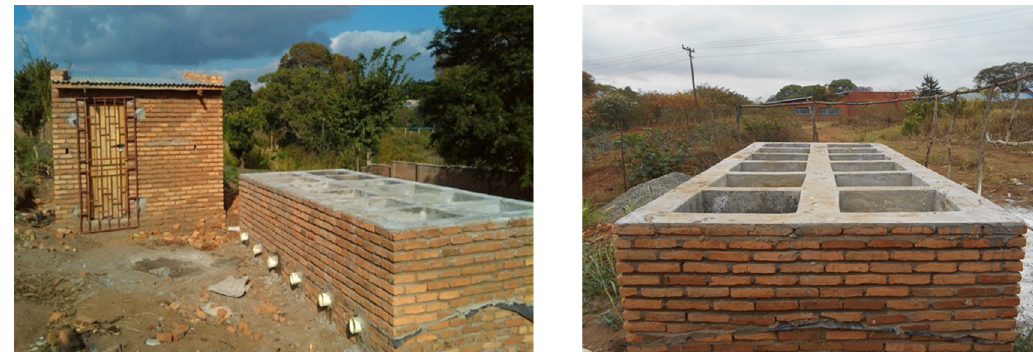
Figure 1. Unplanted drying beds prototype .